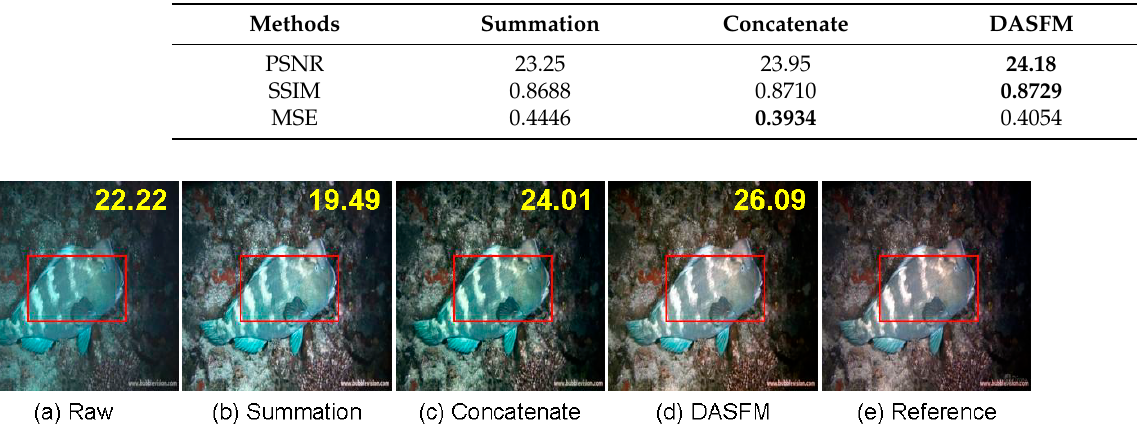
Figure 15. Visual results of different fusion methods. The number on each image represents its PSNR score.